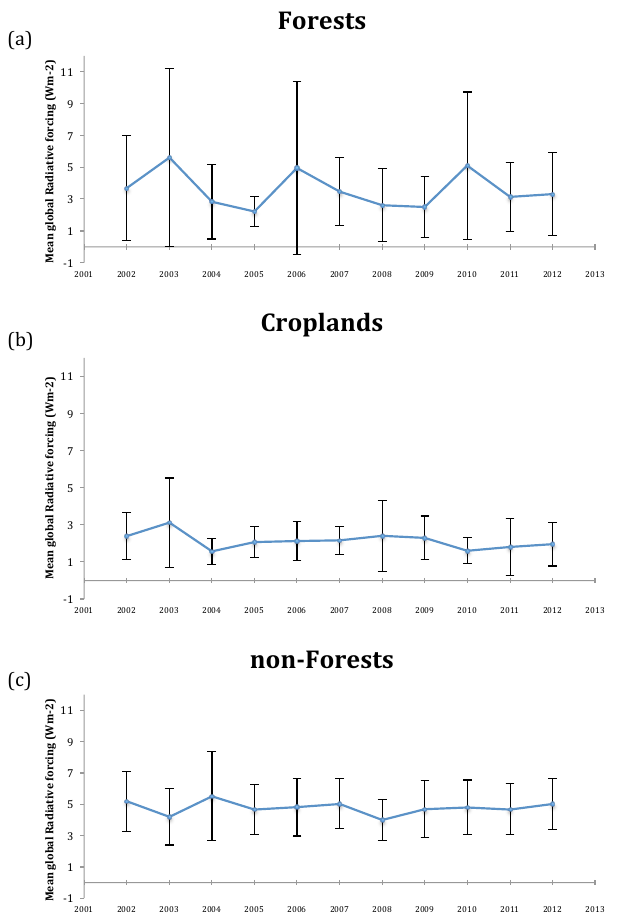
Figure 4. The mean annual radiative forcing per land cover (a–c) in Wm − 2 .